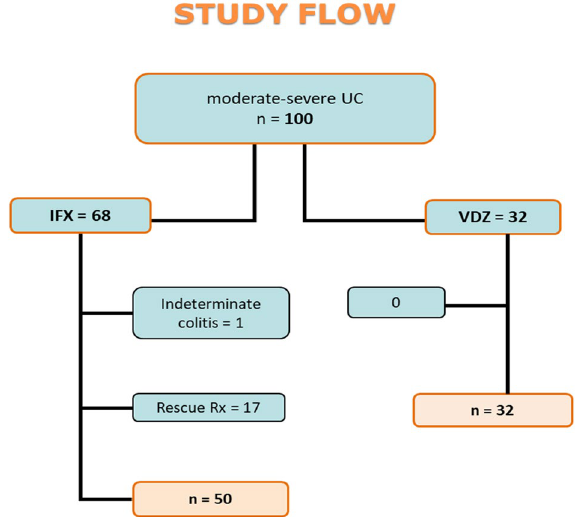
Figure 1. Study flow chart.